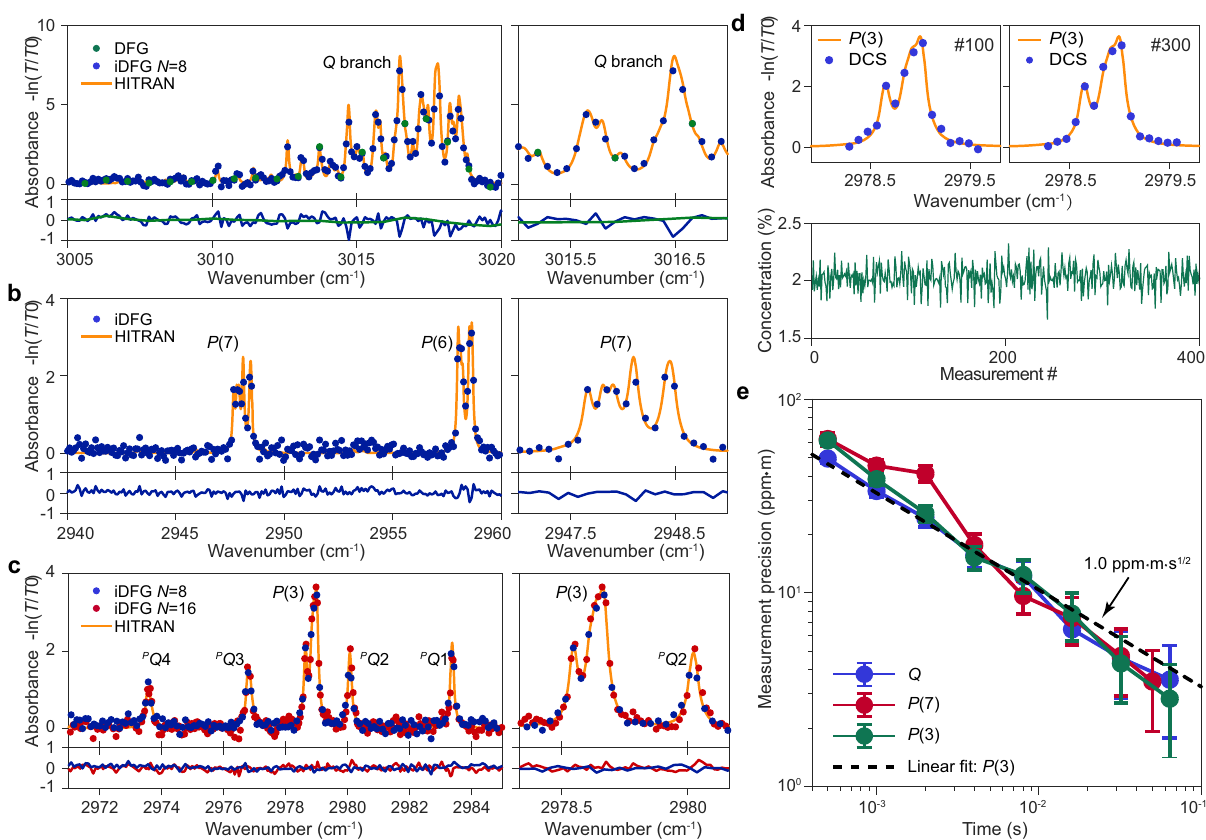
Fig. 3 Dual-comb spectroscopy (DCS) of methane and ethane mixture using iDFG mid-IR combs. a Absorbance spectrum for the methane ν 3 band Q branch using DFG and iDFG ( N = 8). iDFG improves the spectral resolution compared to the 22 GHz mid-IR generated by conventional DFG. HITRAN data are indicated by the yellow line. The right panel (and in b, c ) is a zoom-in of absorption features. The `observed-HITRAN' residuals are shown in the lower panel (also in b, c ). b DCS absorbance spectrum of the methane P (6) and P (7) branches in the ν 3 band measured using iDFG with N = 8. c Absorbance spectrum of the methane P (3) branch in the ν 3 band together with the ethane rovibrational transitions in the ν 7 band. Since ethane has a narrower absorption linewidth, iDFG with N = 16 was also used to further improve the spectral resolution. d Top panels are DCS spectra of the methane P (3) branch (iDFG N = 8), each measured over 0.5 ms duration within a 200 ms measurement window. 100th and 300th spectra of 400 total are displayed. Fitting the spectrum to the HITRAN database yields the methane concentration. The lower panel plots the concentration for the 400 time slots. e Normalized measurement precision of methane concentration evaluated by Allan deviation using different rovibrational transitions belonging to different branches with iDFG N = 8. The error bar corresponds to the standard deviation of the Allan deviation. The Allan deviation of the measured concentration (e.g., lower ffiffiffi p τ panel in d ) is calculated and normalized to a 1 m optical path. The precision scales nearly as 1 = and the dashed line is the corresponding linear fi t using a ffiffiffi p ffiffiffi p τ 1 = trend line (log − log) for the P (3) branch. A precision of 1.0 ppm ⋅ m (cid:1) s is fi tted.